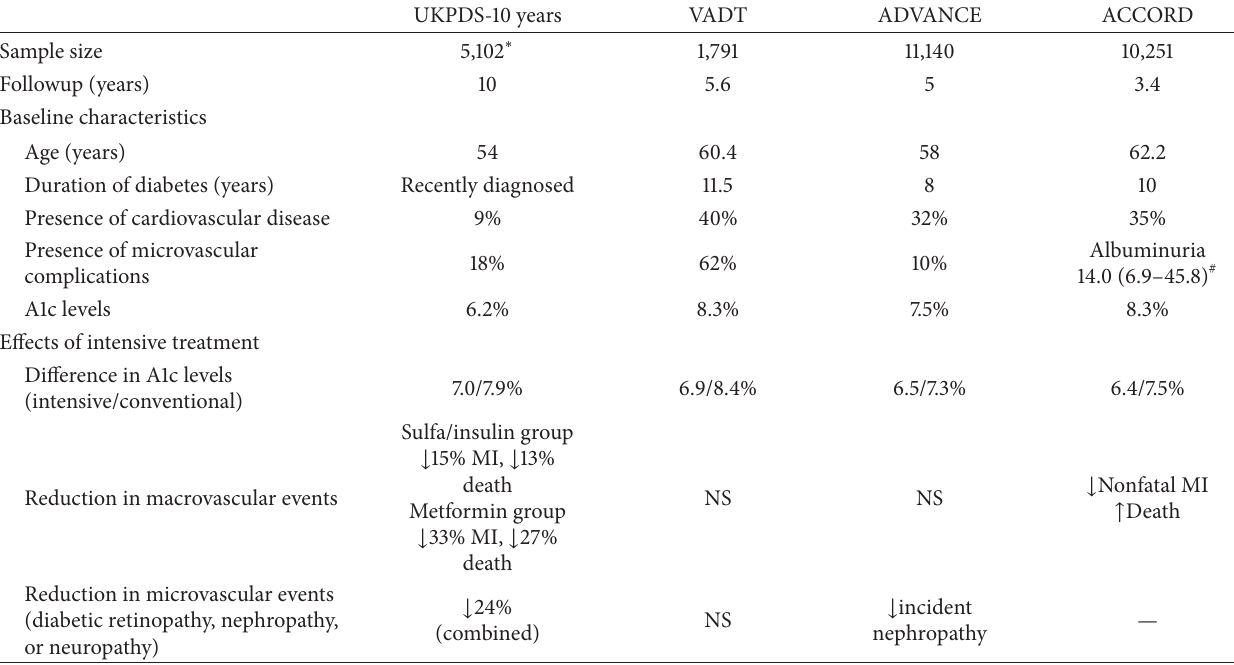
Table 1: Differences of the effects of glycemic control in cardiovascular risk reduction in type 2